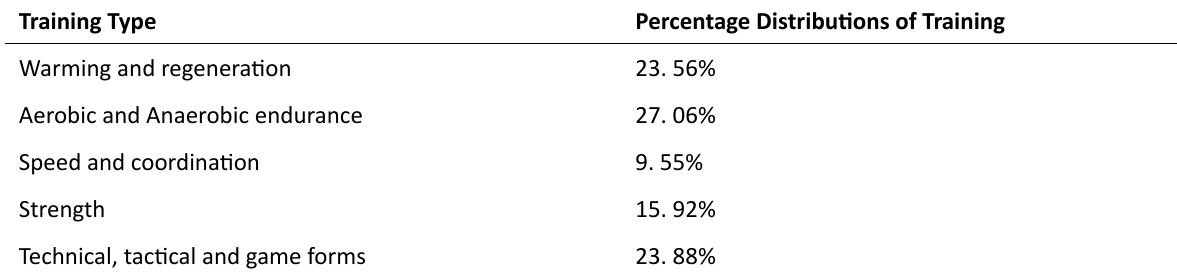
Table 2. Strength training program applied to football players